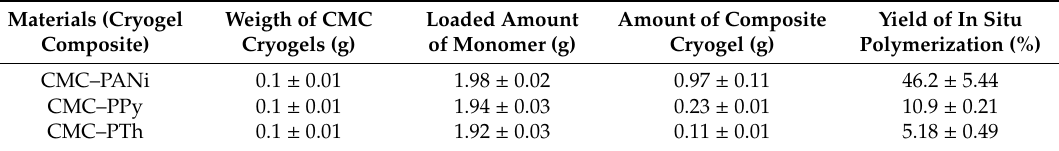
Table 1. The amount of loaded Aniline (ANi), Pyrrole (Py), and Thiophene (Th); the amount of in situ synthesized cryogel composites; and in situ polymerization yield. CMC, carboxymethyl